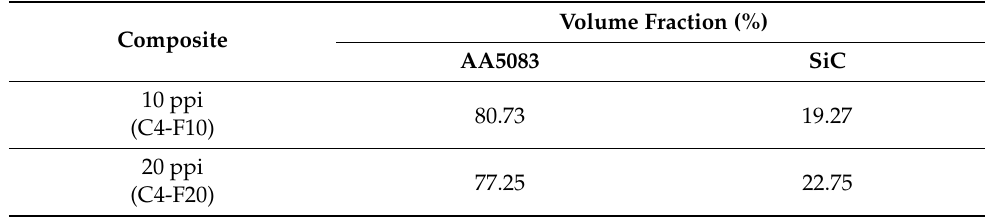
Figure 5. Microstructure of as-cast composite samples: ( a ) C4-F10; and ( b ) C4-F20. Table 6. Volume Fraction of the C4.